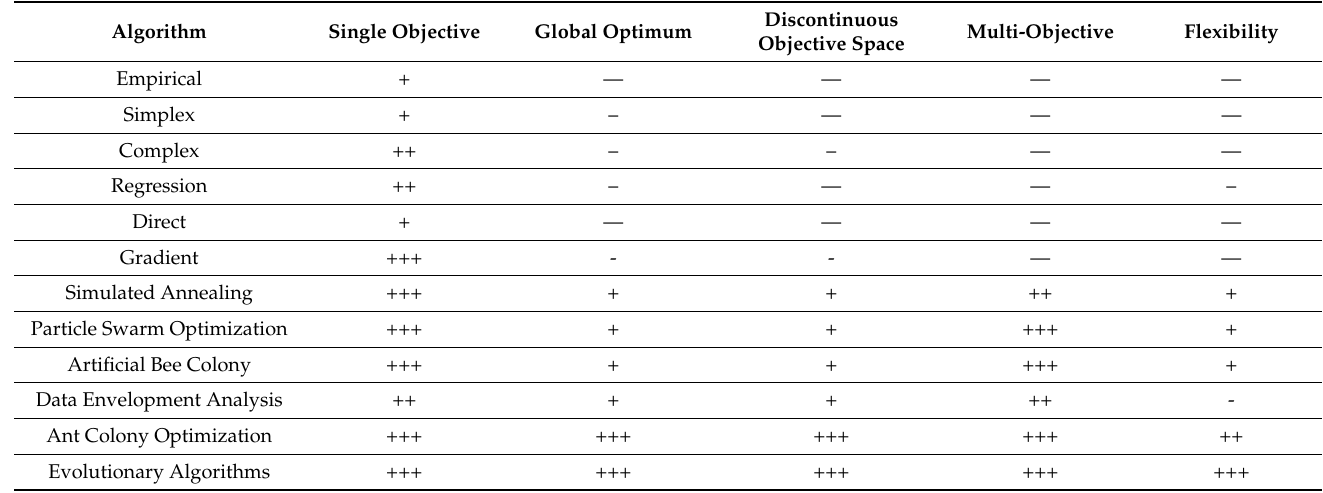
Table 1. Classification of the optimization algorithms adequacy and efficiency: “—”, not adequate; “–”, very inefficient; “-”, inefficient; “+”, adequate; “++”, efficient; “+++”, very